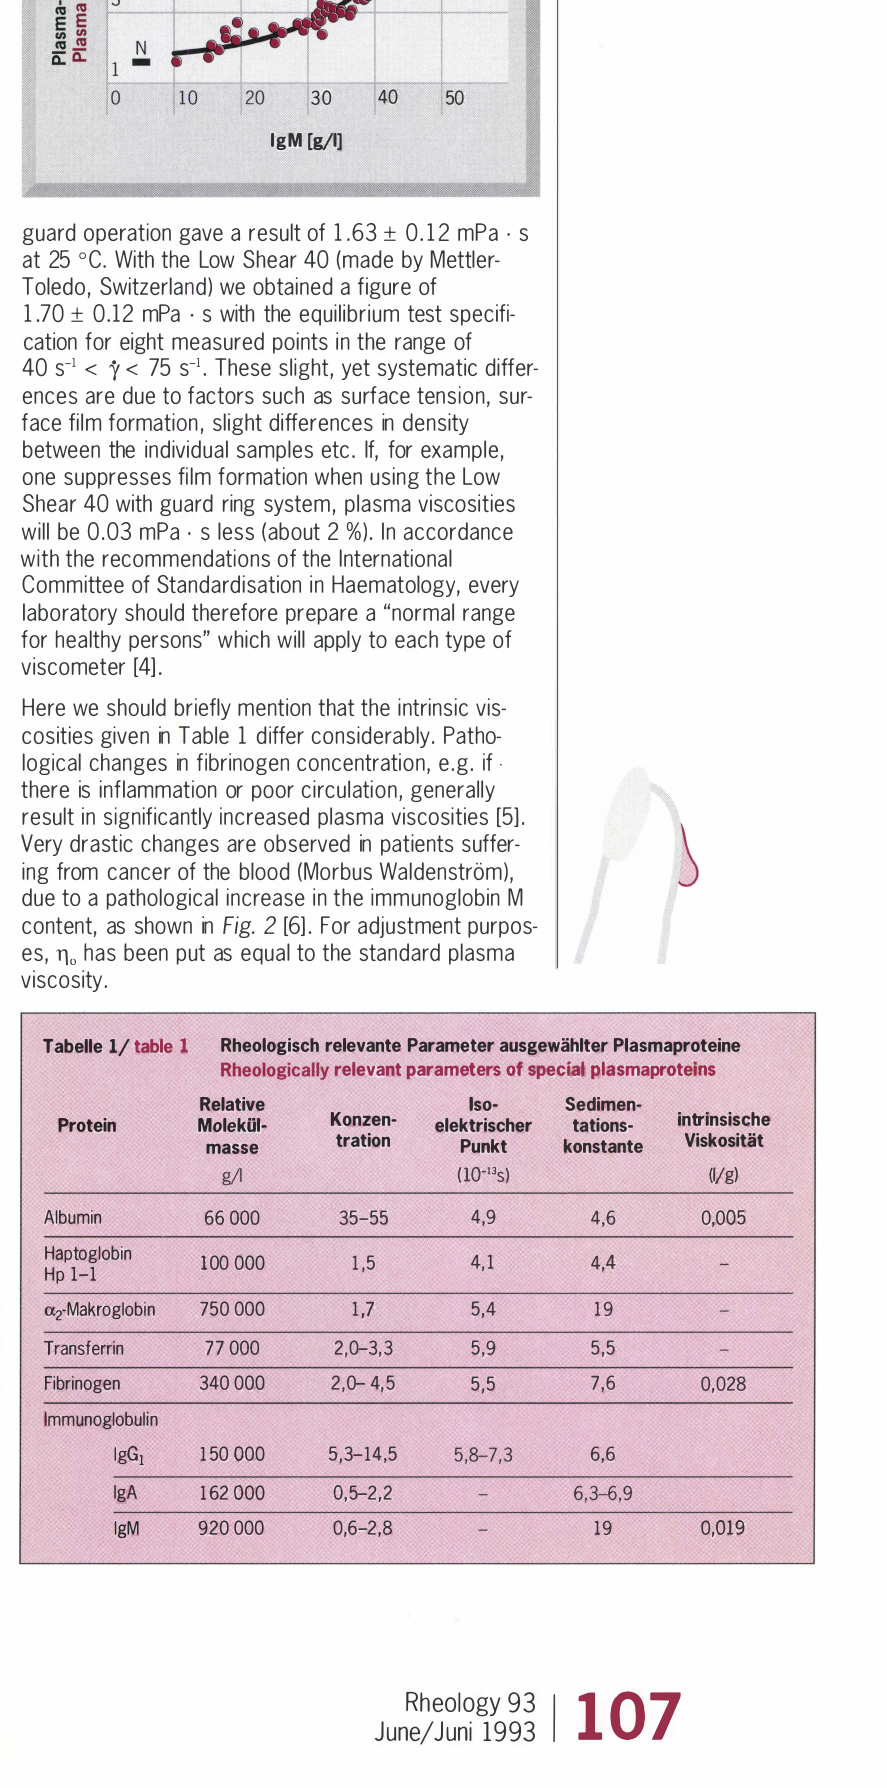
Fig. 2: Plasma viscosity as a function of the lgM concen­ tration for M.-Wa/denstriim